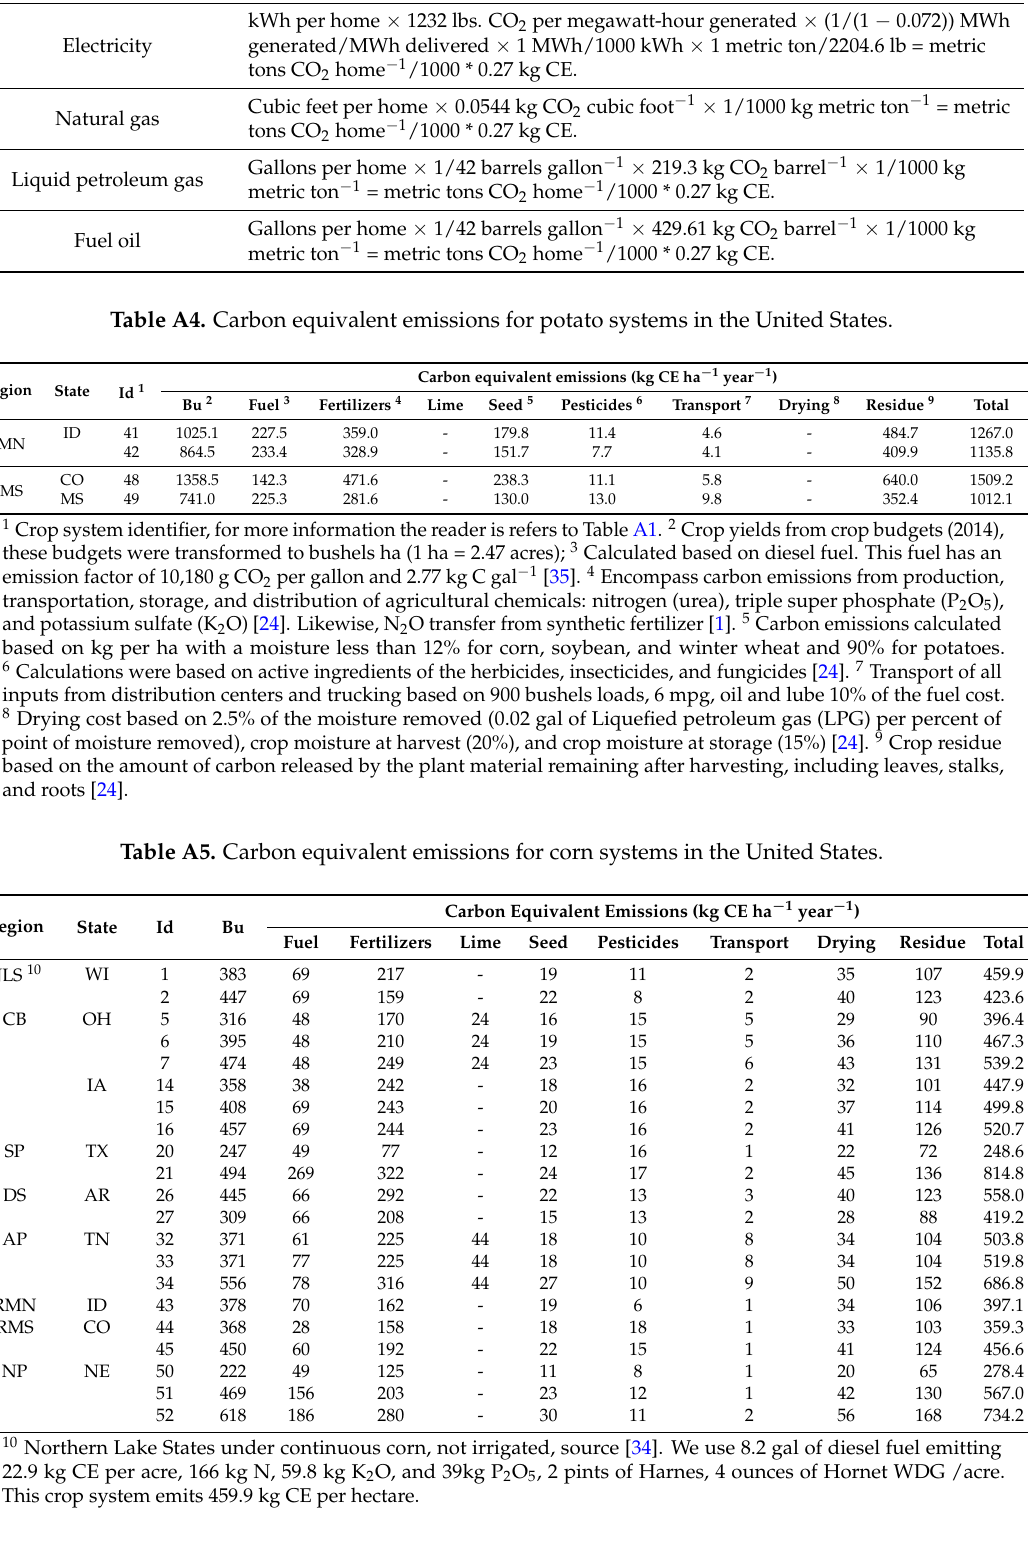
Table A3. Description of the protocol to convert different energy sources into kg CE. Energy Source Process to Convert Energy Sources into kg CE